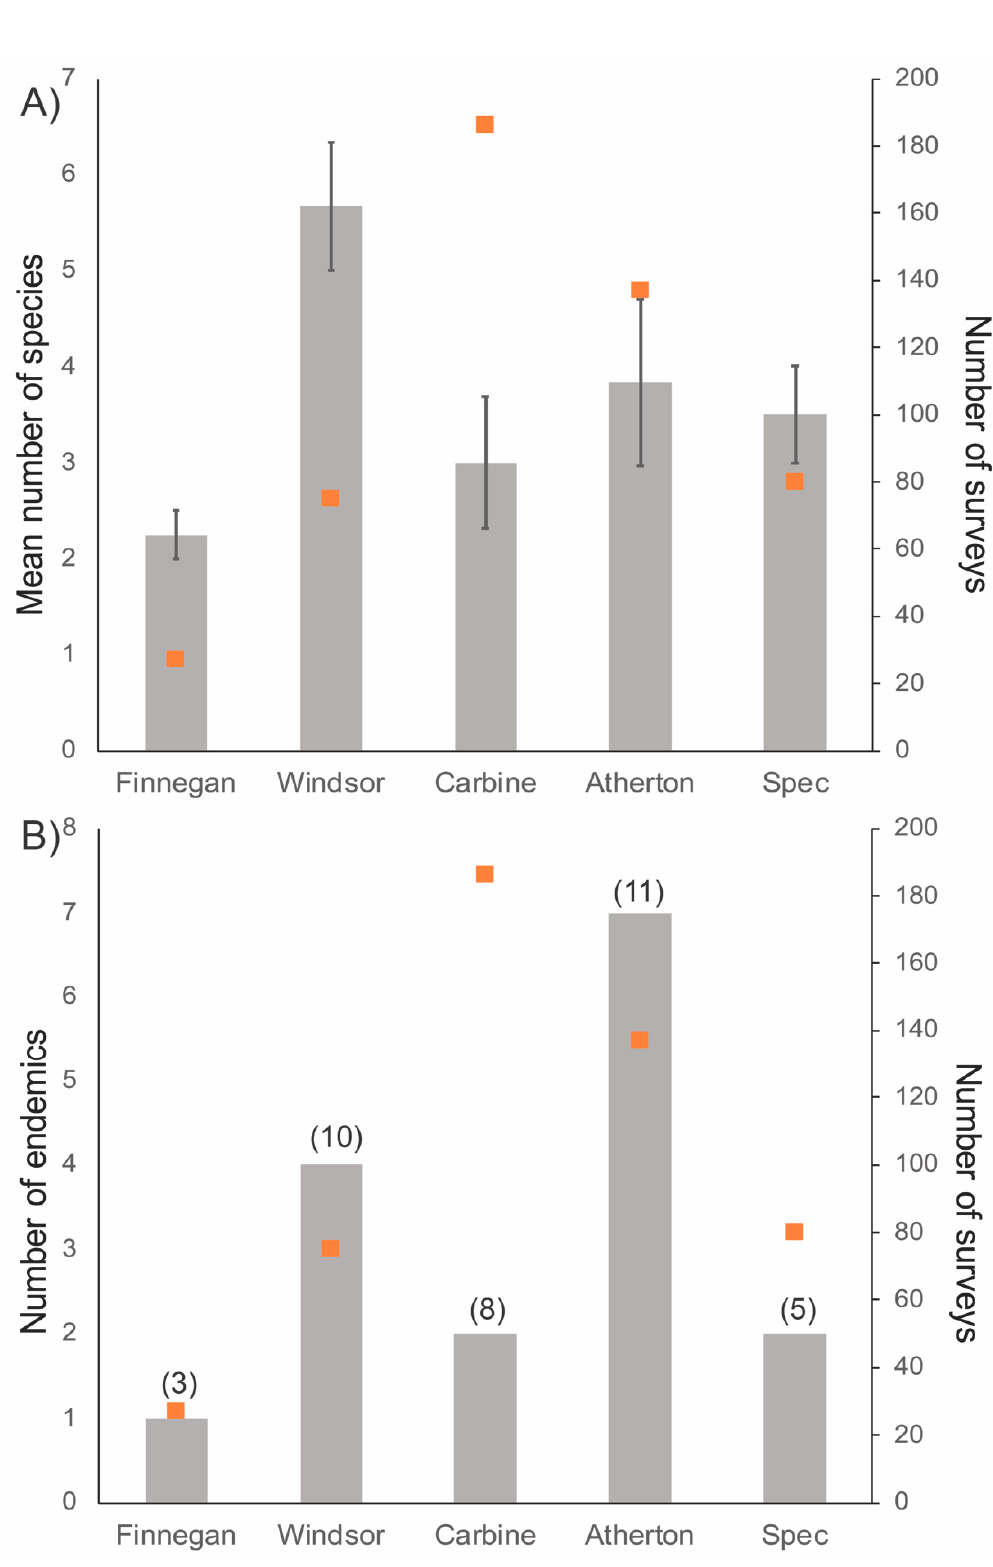
Figure 12. Variation in diversity and endemism among subregions. Subregions labelled from left to right along the north to south latitudinal gradient. ( A ) Mean (±SE) number of Anonychomyrma species per elevational site as grey bars and number of surveys per subregion as orange symbols. ( B ) Number of subregion endemics per subregion, and in brackets, the total species richness per subregion. Orange symbols are number of surveys per subregion.